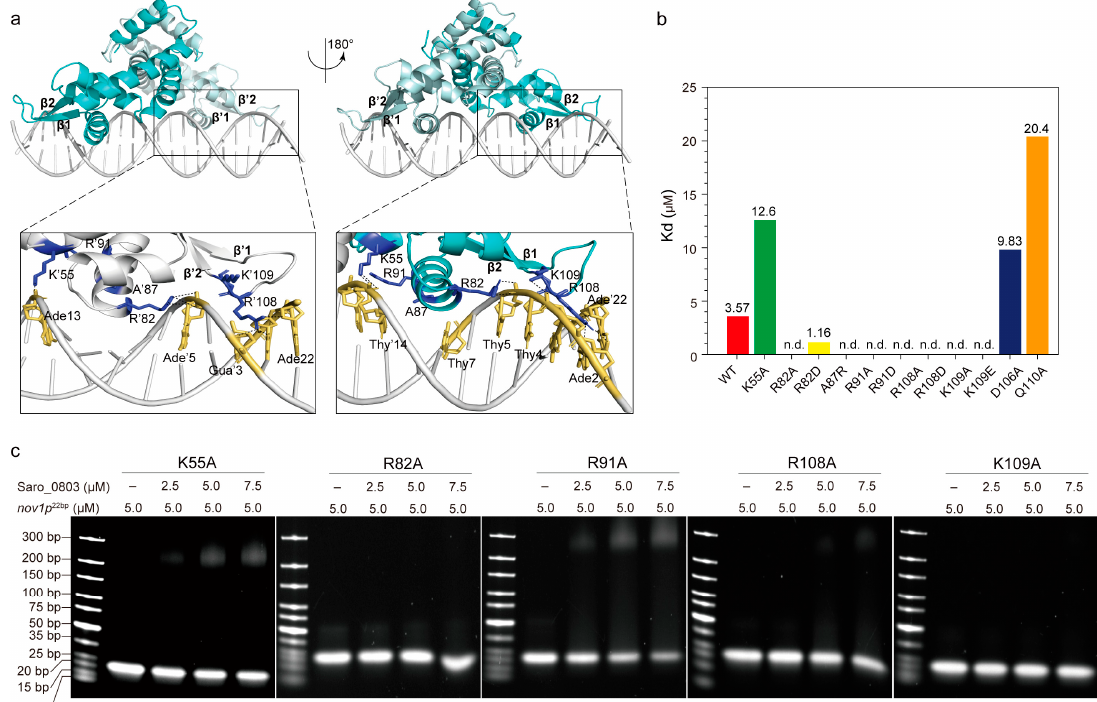
Figure 4. Investigation of the interaction pattern of Saro_0803 binding with nov1p 22bp . ( a ) Overall, the molecular docking model of Saro_0803 bound to its operator DNA sequence nov1p 22bp , repre- sented in two orientations with 180° rotation. The dark box indicates the location of protein–DNA interactions. Close-up view of the bilateral protein–DNA interactions, where residue K55 and the residues of helix α 4/ α′ 4 are bound to the major groove and a looped region between strands β 1- 2/ β′ 1-2 to the minor groove, respectively. ( b ) The colored column diagram of binding affinity (K d ) of the interaction between the wild type or mutants of Saro_0803 and nov1p 22bp determined by ITC experiments. ( c ) EMSA analysis of the interaction between the wild type or mutants of Saro_0803 and nov1p 22bp , where the increased concentration of protein with 0, 2.5, 5.0, and 7.5 µM were incu- bated with 5.0 µM DNA sequence nov1p 22bp .